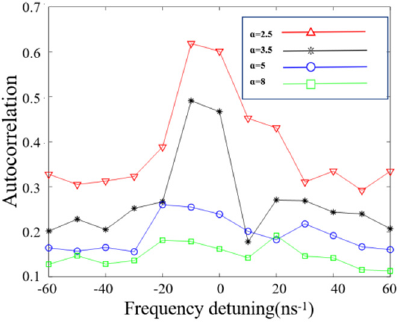
Figure 5. The line diagram of TDS as the frequency detuning between MSRL and SSRL varying from − 60 GHz to 60 GHz, while red triangles denote α = 2.5, black stars denote α = 3.5, blue circles denote α = 5, green squares denote α = 8.